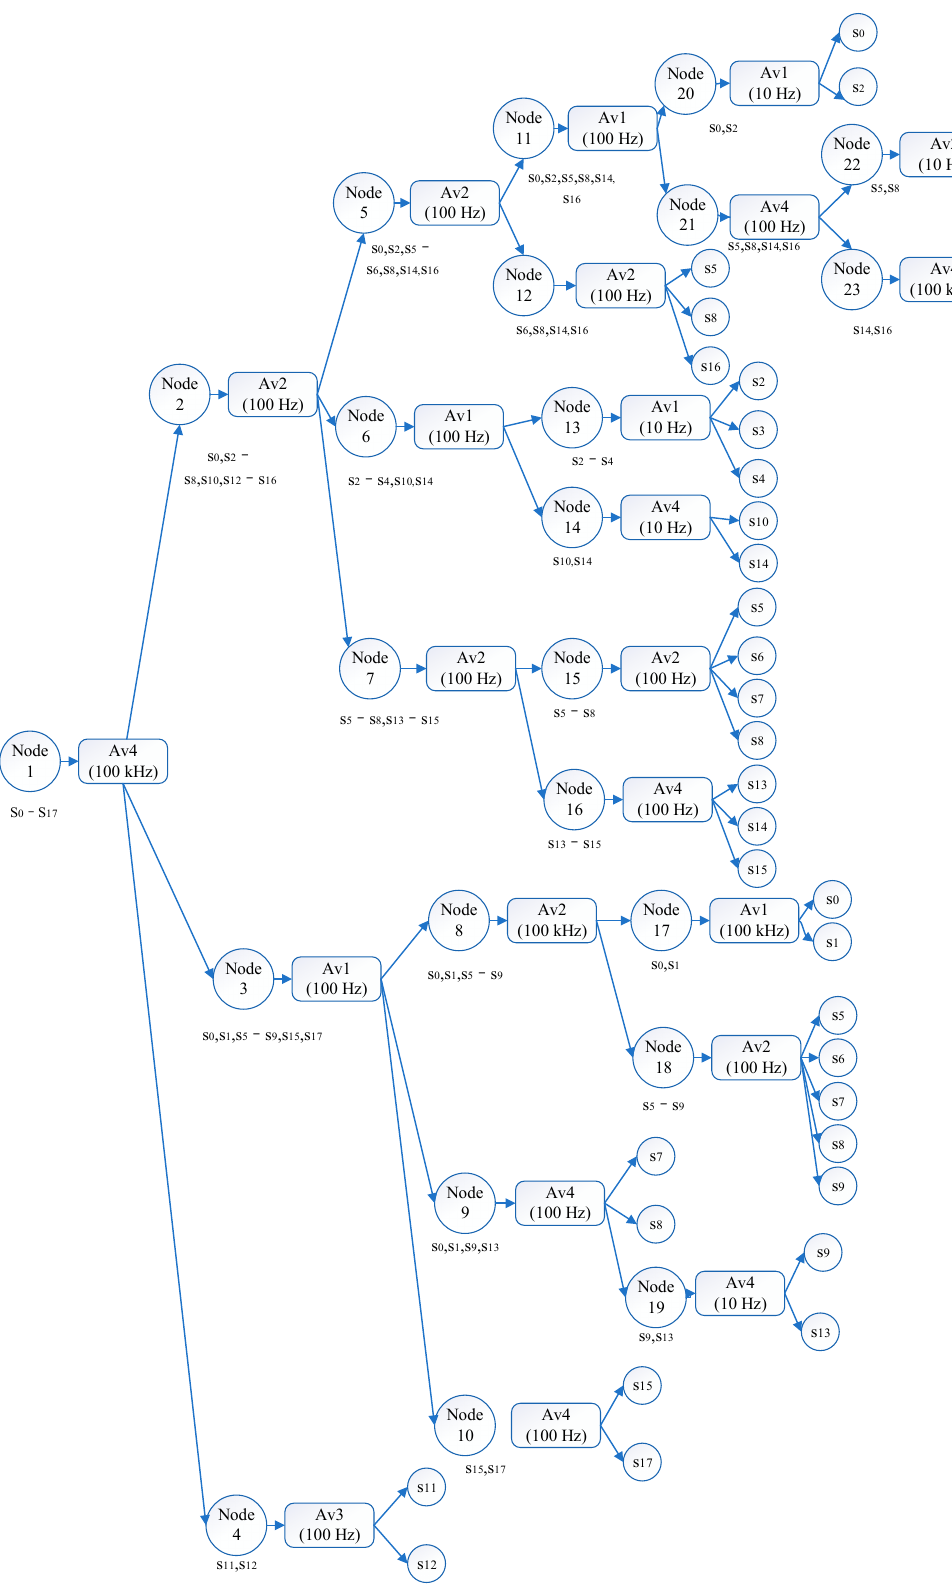
Figure 6. Analog circuit diagnostic tree.